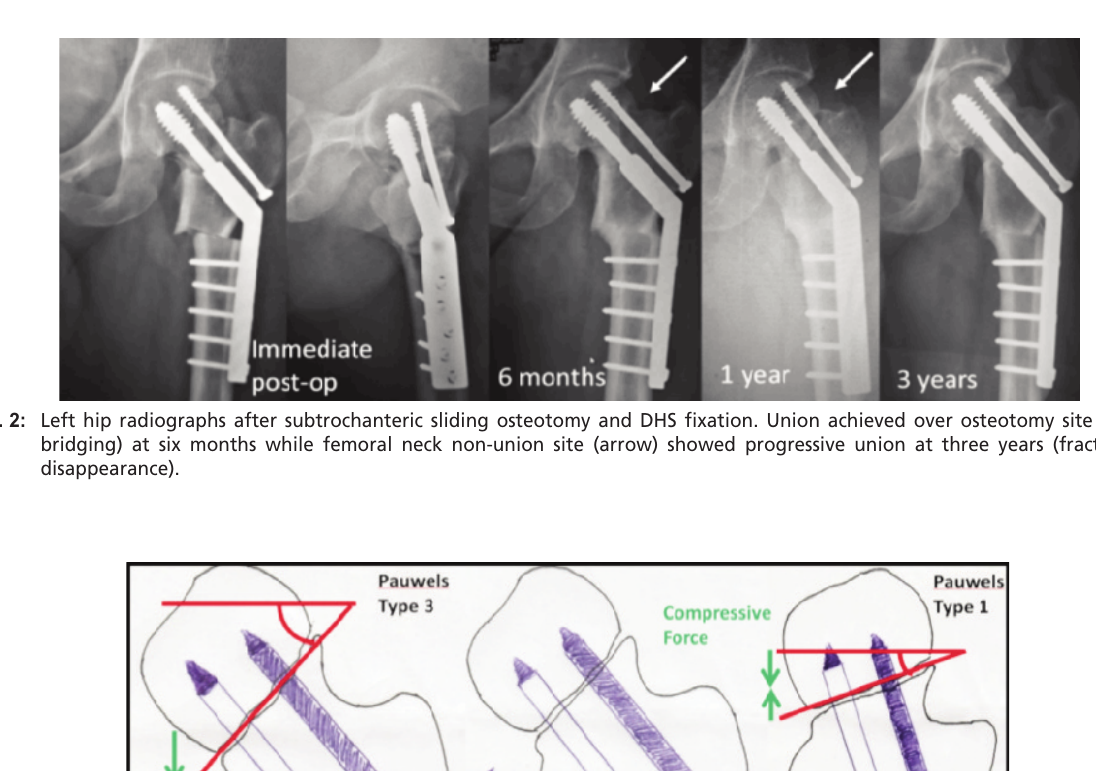
(a) Pelvic radiograph demonstrated left hip basicervical, Pauwels type-3 neck of femur fracture. (b) Pelvic radiograph six months Fig. 1: after two cannulated screws fixation, noted non-union over fracture site evidenced by no bridging callus formation and sclerotic fracture edge.